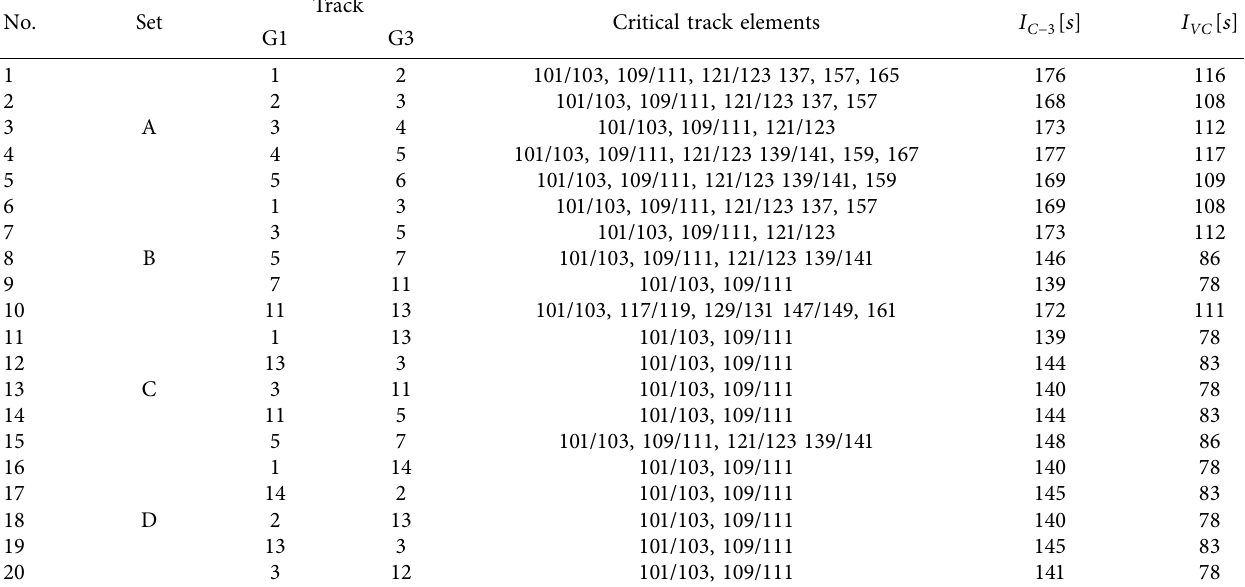
Table 9: Outcomes of train headways in scenario 5.